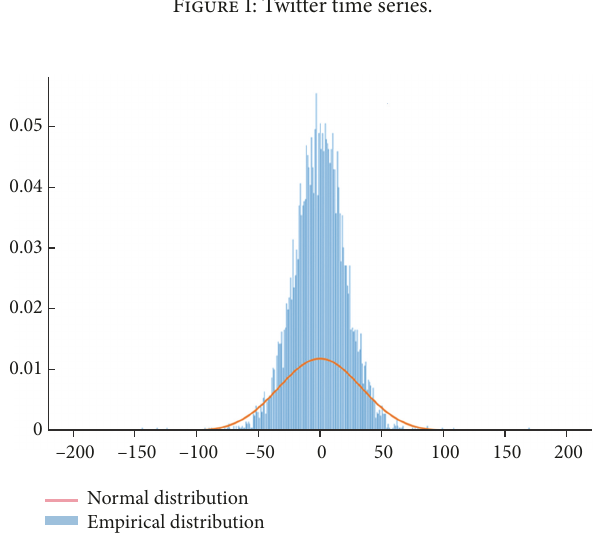
Figure 2: Normal and empirical